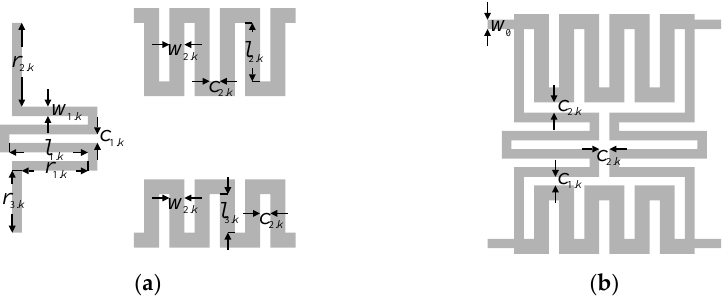
Figure 7. Compact BLC with flexible phase difference: ( a ) individual sections of the structure and ( b ) geometry of the assembled circuit.